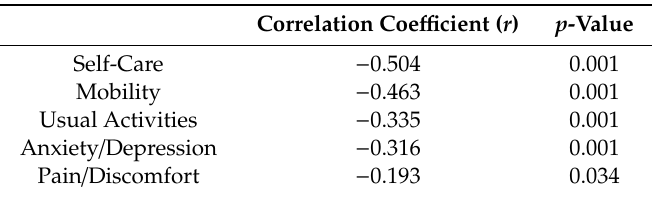
Table 3. Correlation values between Health-related EQ VAS and EQ-5D values, within the five domains Mobility, Self-Care, Usual Activities, Pain / Discomfort and Anxiety / Depression. Spearman’s rho, correlation coefficient ( r ). Correlation Coe ffi cient ( r ) p -Value Self-Care − 0.504 0.001 Mobility − 0.463 0.001 Usual Activities − 0.335 0.001 Anxiety / Depression − 0.316 0.001 Pain / Discomfort − 0.193